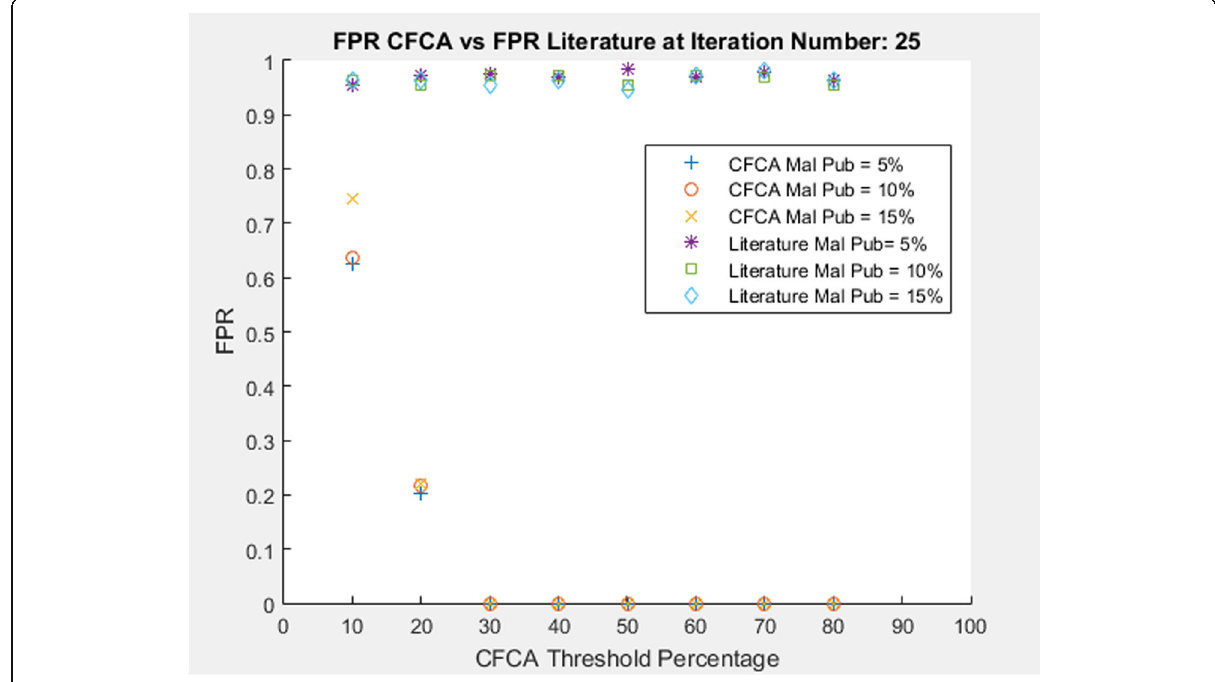
Fig. 5 FPR CFCA vs FPR literature at iteration I =